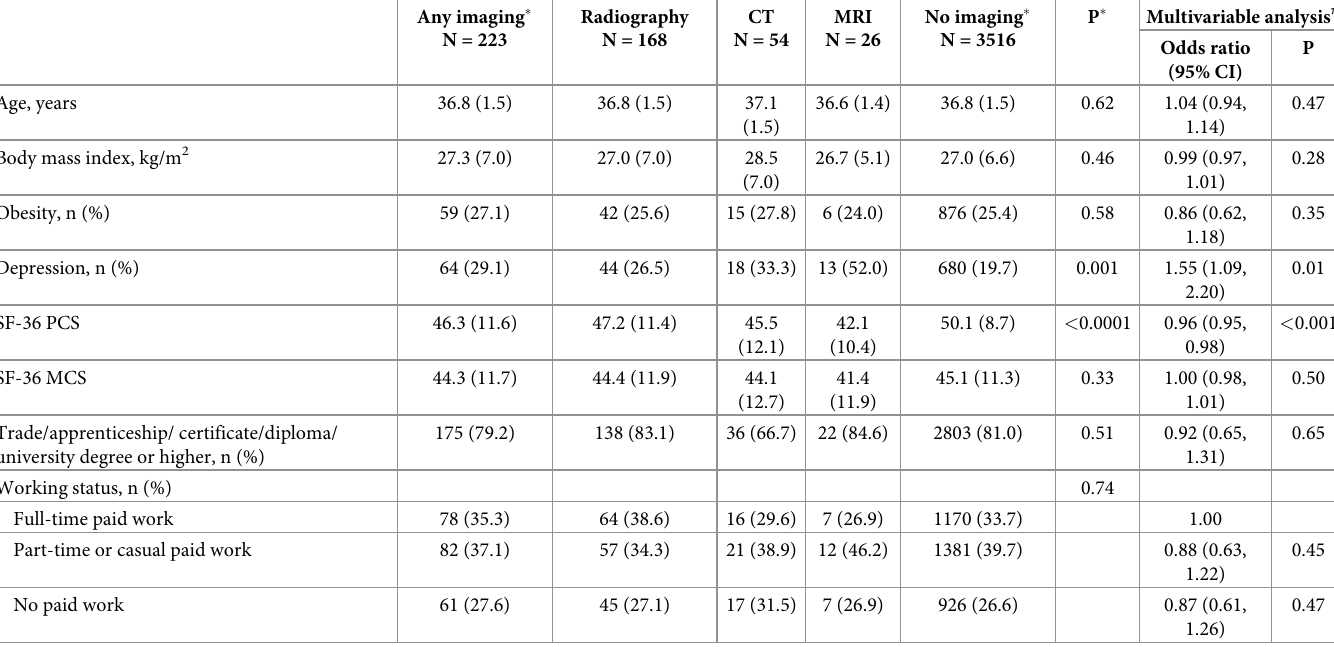
Table 4. Participant characteristics and use of lumbar spine imaging in participants with self-reported back pain in the last 12 months. Any imaging � N =